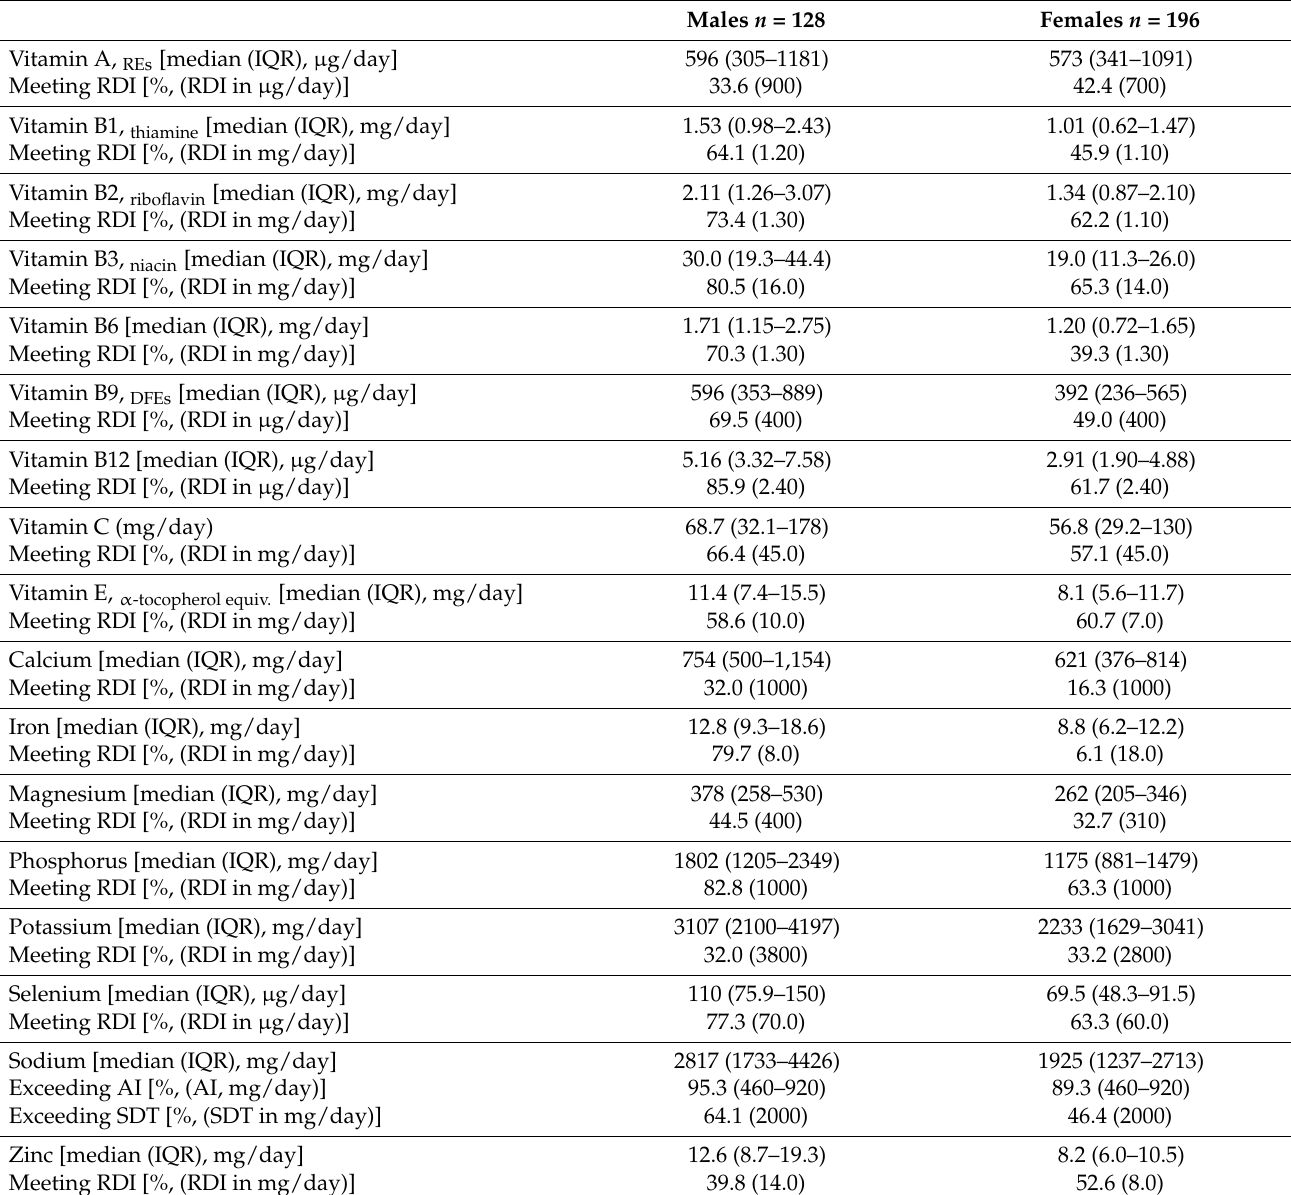
Key micronutrient deficiencies for both sexes included vitamin A, calcium, and potas- sium, with less than half of all students meeting the recommended dietary intake (RDI) (Table 3). Other deficiencies for females included thiamine, vitamin B6, iron, and magne- sium. Of particular concern were calcium and iron, with the RDI being met by only 16% and 6% of female students, respectively. Using the estimated average requirement (EAR) as the reference, calcium and iron intakes were met by 23% and 59% of female students, respectively. Zinc was the only nutrient deficiency specific to males, with less than 40% meeting the RDI. For sodium, almost all students (89–95%) exceeded the AI level, and the majority of males (64%) and almost half of all females (46%) exceeded the suggested dietary target (SDT). Table 3. Micronutrient intake and current